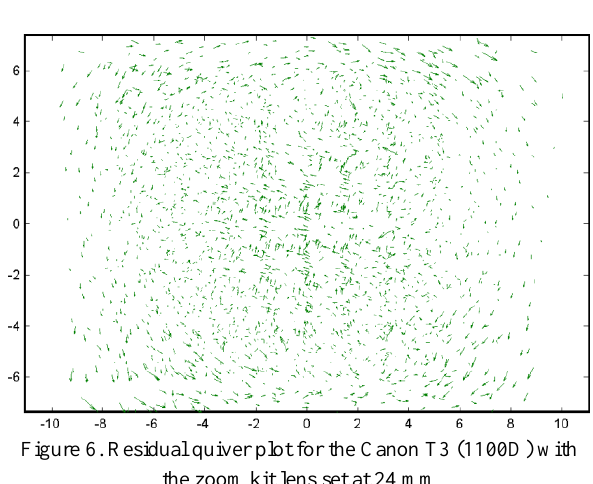
Figure 5. Residual quiver plot for the Canon XT (350D) with the zoom kit lens set at 24 mm